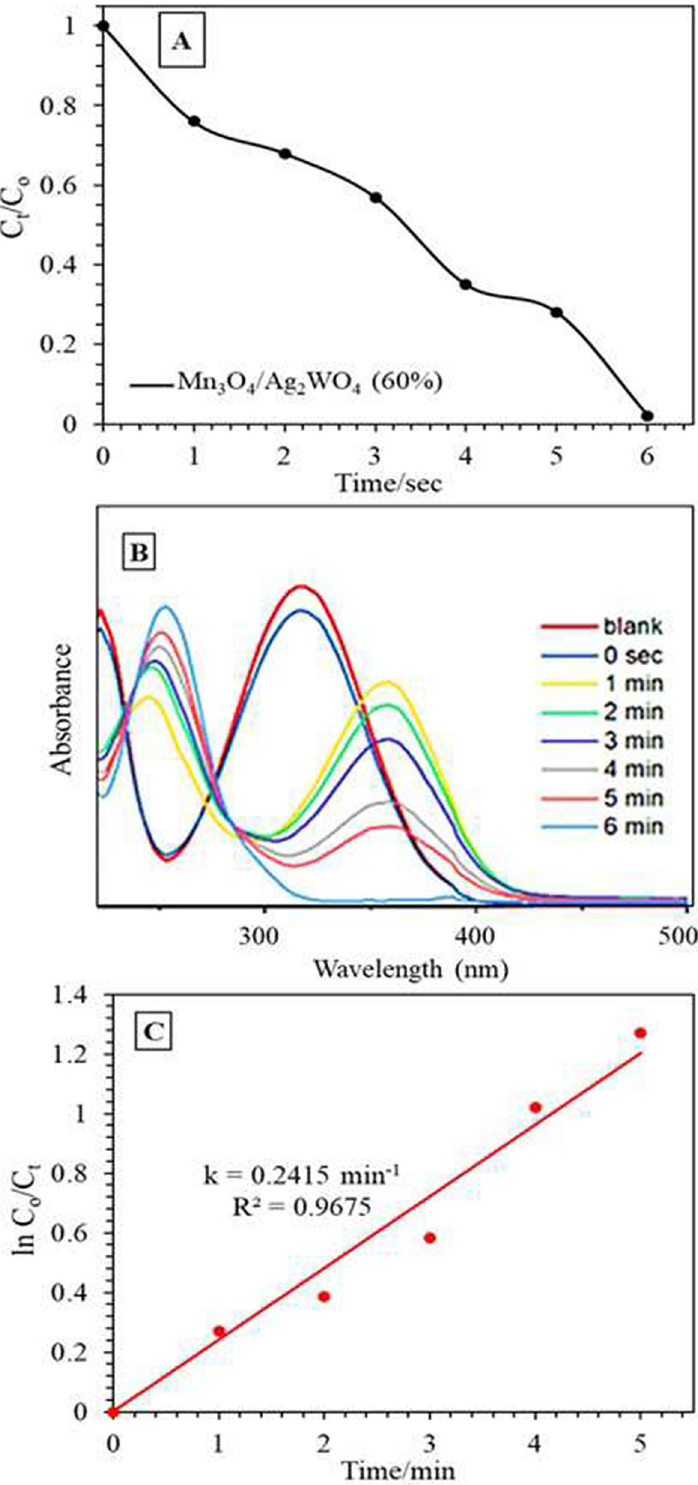
Figure 10. ( A ) The change in the concentration of 4-Nitro acetanilide with time on the Mn 3 O 4 /α-Ag 2 WO 4 (60%) photocatalyst, ( B ) UV–vis absorption spectra of the reduction of 4-Nitro acetanilide and ( C ) Plots of ln (A t /A 0 ) versus time. Reaction conditions: 100 mL 4-Nitro acetanilide of conc. 0.001 M, NaBH4 conc. of 0.2 M, 0.1 g catalyst, T = 289 K, Led lamp 50